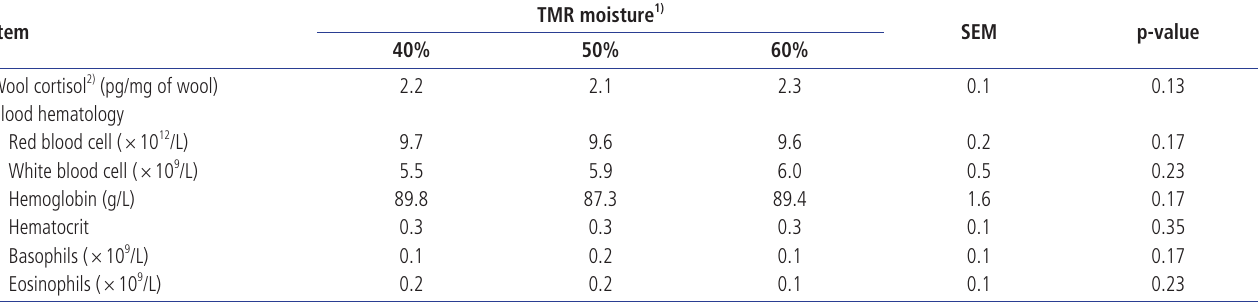
Table 6. Effects of adding water to TMR on wool cortisol and hematologic characteristics in ewes during hot and humid conditions